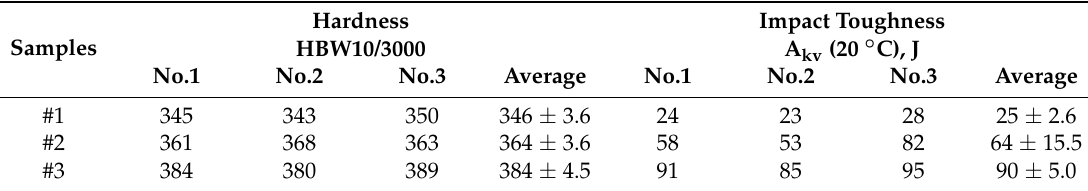
Table 4. Mechanical properties of CGHAZ.